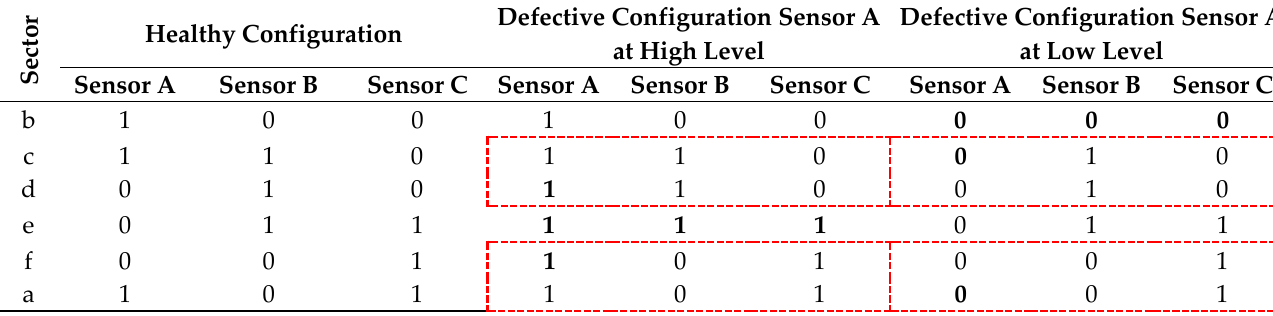
Table 3. The healthy commutation sequence compared to the single breakdown fault of position sensor A at different states.